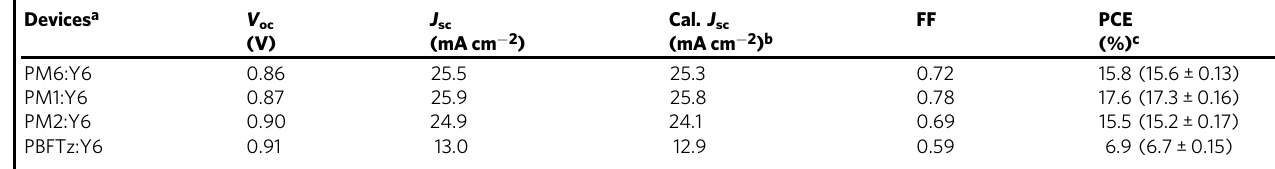
The corresponding external quantum ef fi ciency (EQE) spectra of the optimized devices with or without CN were measured to con fi rm the accuracy of the PCE measurements. As shown in Fig. 1e, all the EQE spectra of the devices cover a broad spectral response range from 300 to 930 nm, which is in agreement with the corresponding good complementary absorption spectra of the polymers and Y6. For the PM1-based devices, the EQE responses exceed 80% in the range of 500 – 810 nm, and the maximum EQE of 84% is achieved at 560 nm, which is superior to the values of the other three devices. Accordingly, the highest J sc of 25.8 mA cm − 2 is integrated from the EQE spectra of the PM1-based device, which also exceeds the values for the PM6 family polymers and Y6 based devices. Meanwhile, the J sc values calculated by integrating the EQE data agree well with those obtained from the J – V measurements within 3% mismatch.